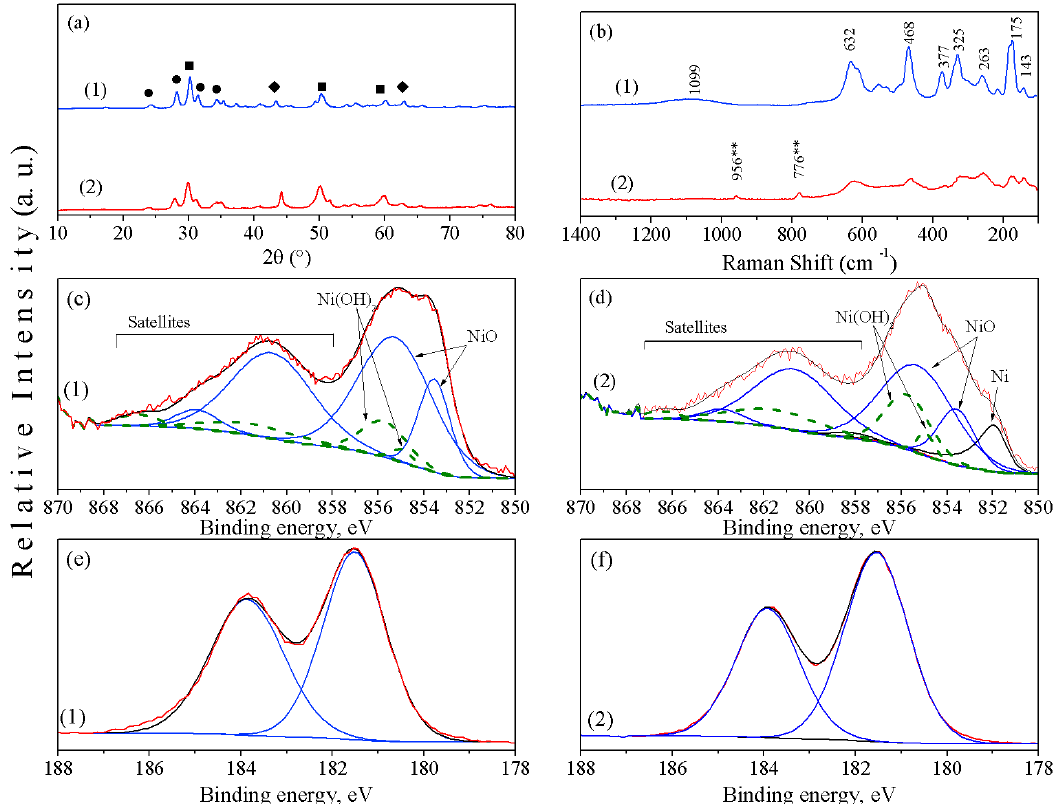
Figure 9. Comparative analysis of the fresh and the spent 20% Ni/ZrO 2-COP catalyst. ( a ) X-ray diffraction, ( b ) Raman spectroscopy, ( c )–( f ) X-ray photoelectron spectroscopy. (1) Spent catalyst, (2) fresh catalyst. ZrO 2 monoclinic phase ( ), ZrO 2 tetragonal phase ( ), nickel oxide ( ), nickel–zirconia interaction (**).